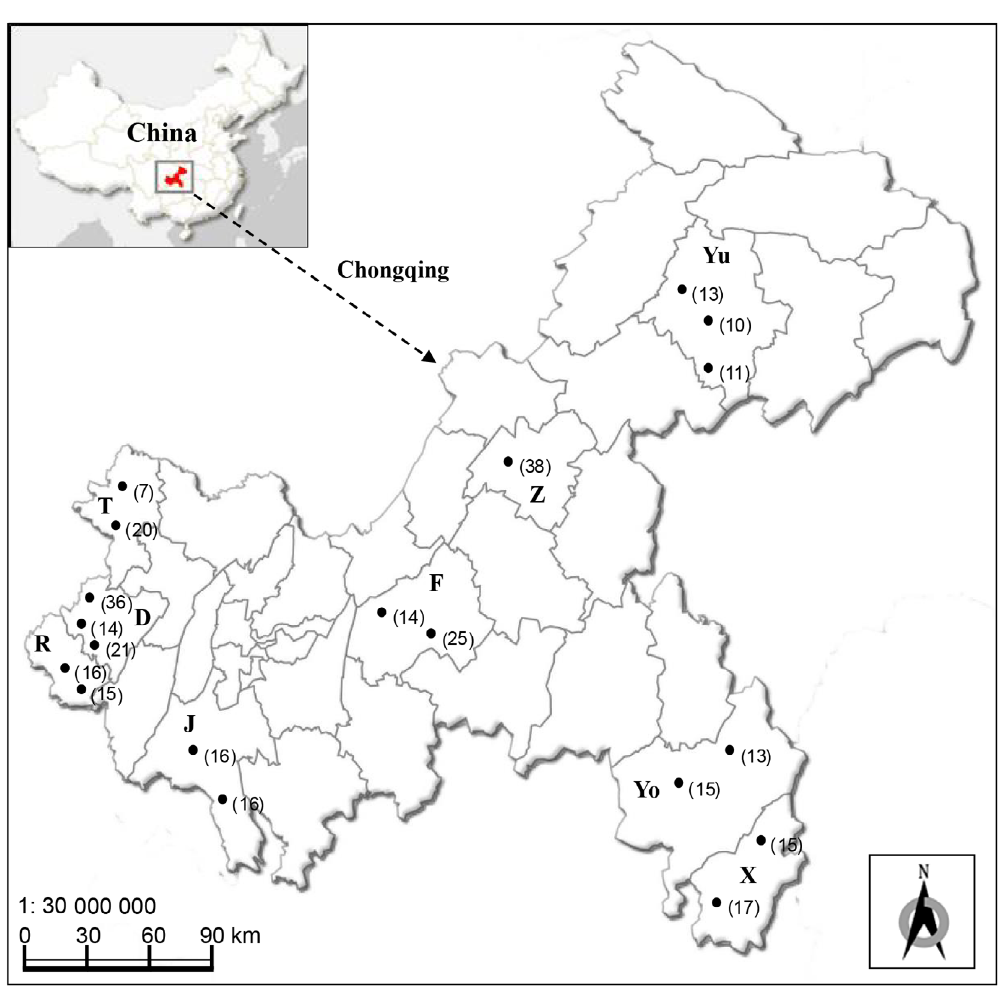
Figure 1. Map of surveyed counties located in Chongqing Municipality, China, where the blood samples of goats were collected. T: Tongnan; D: Dazu; R: Rongchang; J: Jiangjin; F: Fuling; Z: Zhongxian; Yu: Yunyang; Yo: Youyang; X: Xiushan. The black dots indicate the farms. The number of samples collected from the corresponding goat farm is indicated in